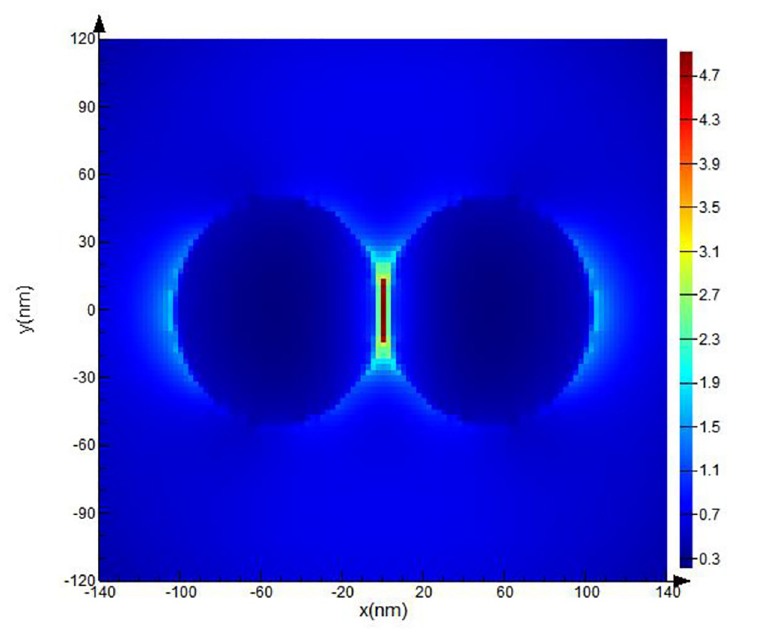
Fig 6. FDTD Pt NPs dimer simulation